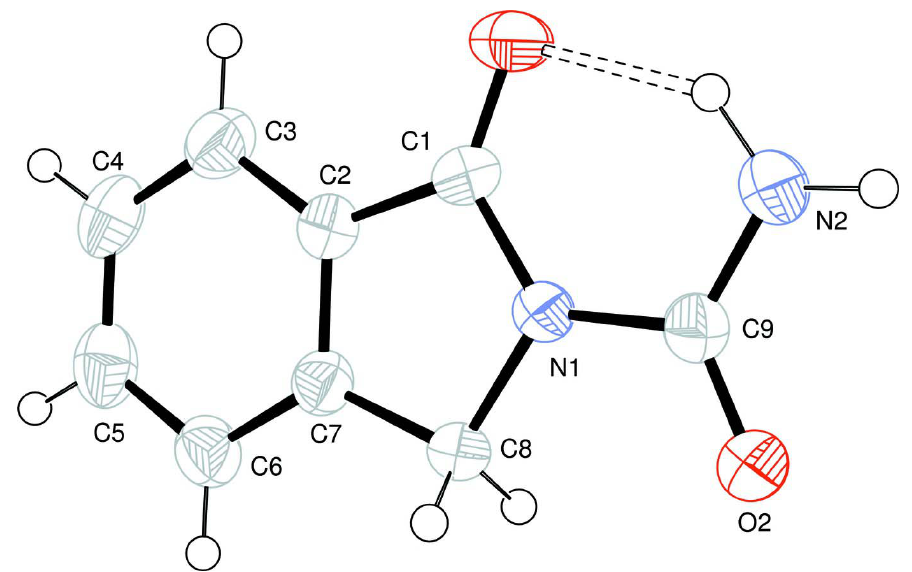
Figure 1 The ORTEP diagram of the title compound (I) with displacement ellipsoids at 50% probability level; intramolecular interaction has been indicated by broken line. H-atoms are shown by small circles of arbitrary radii.